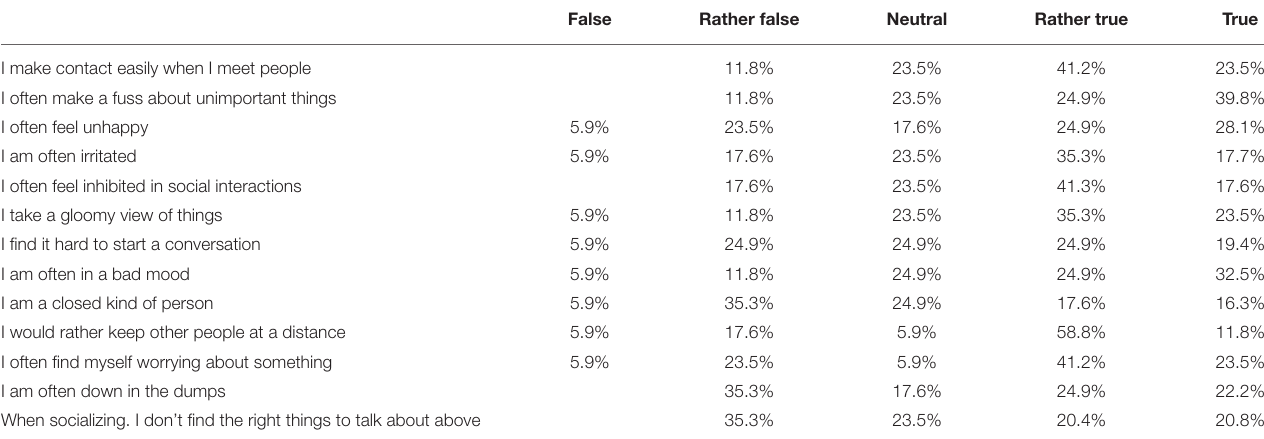
TABLE 3 | Type D personality in the study